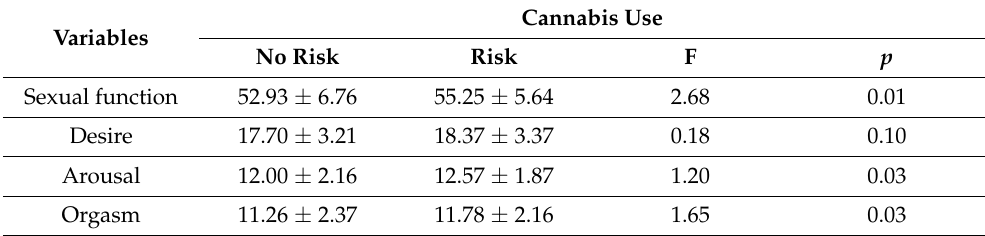
Table 3. The relationship between cannabis use and sexual